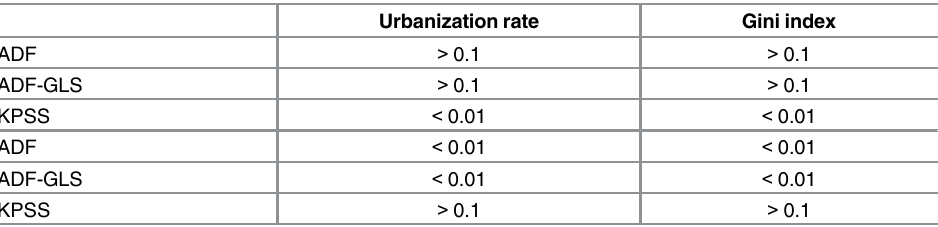
Table 1. Results of unit